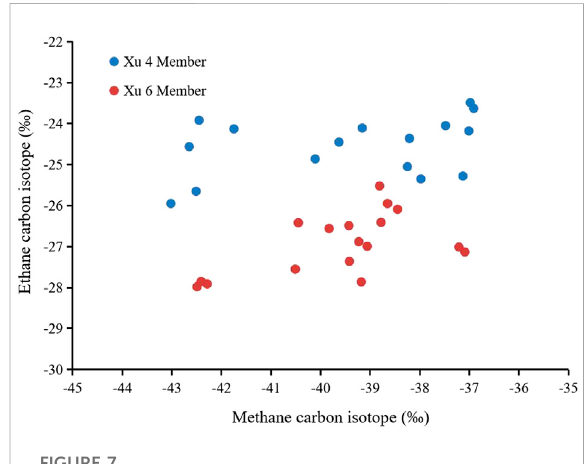
FIGURE 7 Relationship between methane and ethane carbon isotopes in the Xu 4 and Xu 6 Members of Guang ’ an Gas